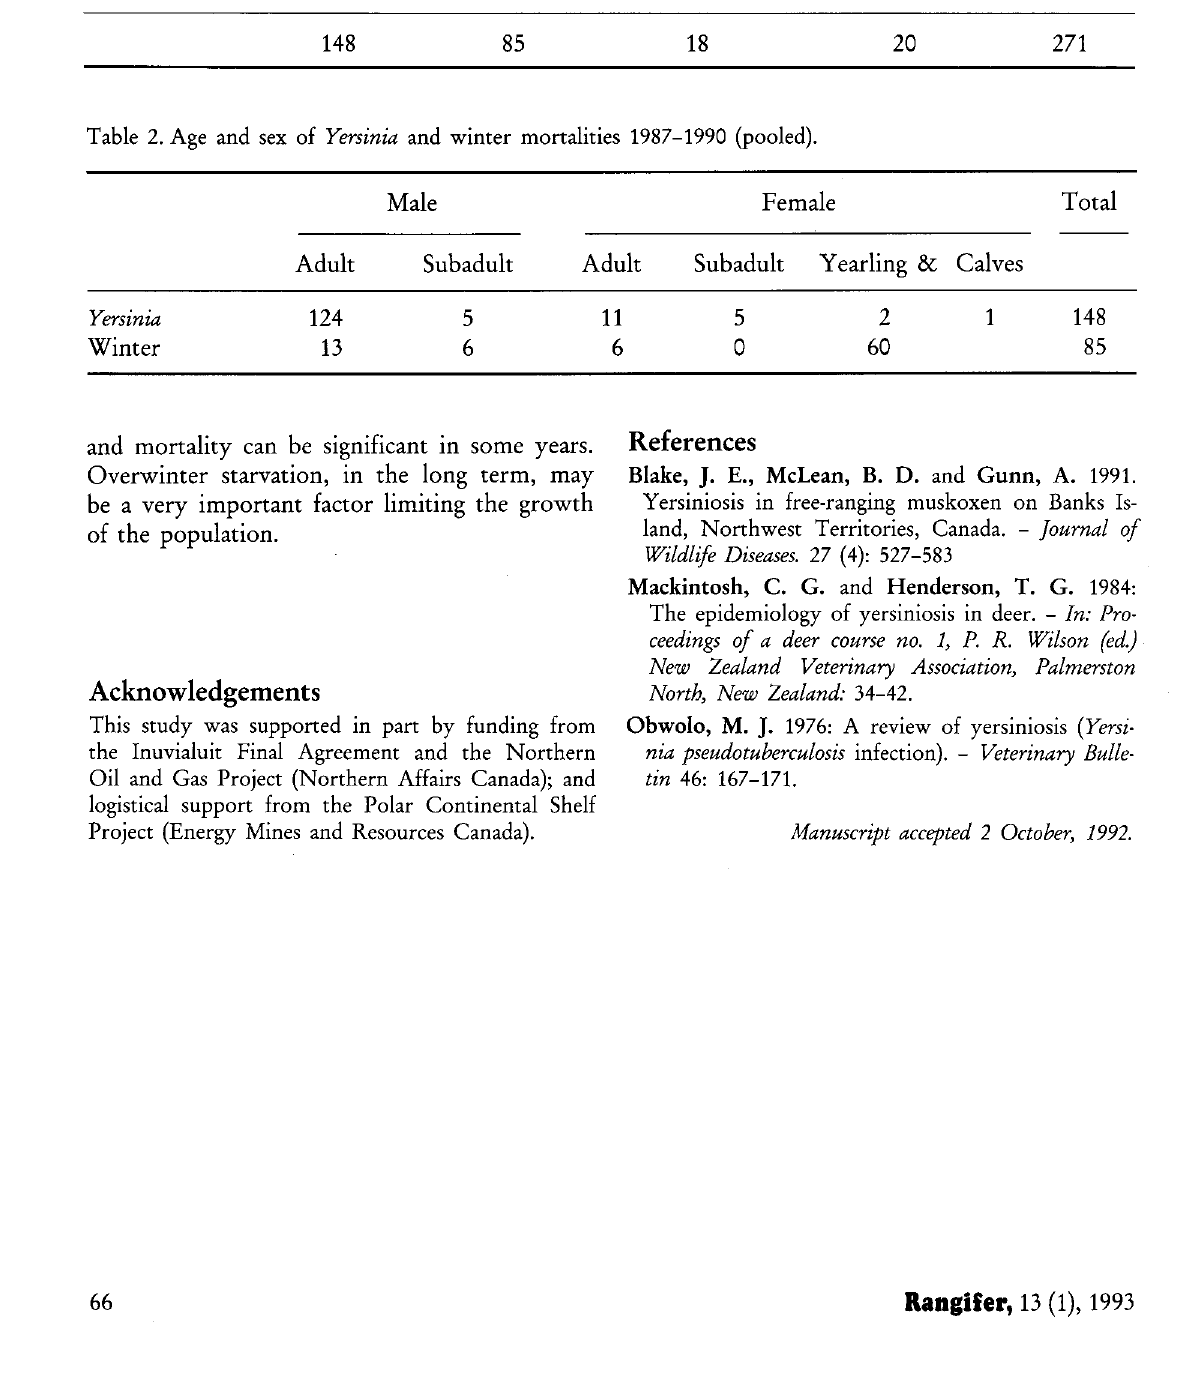
Table 2. Age and sex of Yersinia and winter mortalities 1987-1990 (pooled). Male Female Total Adult Subadult